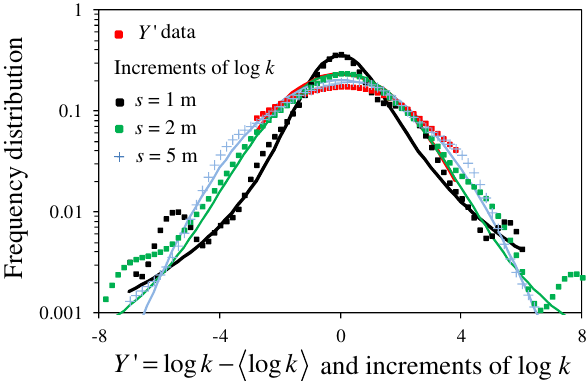
Fig. 3. Frequency distributions (symbols) and ML estimated proba- bility density functions (curves) of Arizona Y 0 = log k −h log k i data (red) and log k increments at lags s =1m (black), 2m (green), and 5m (blue). Figure 4